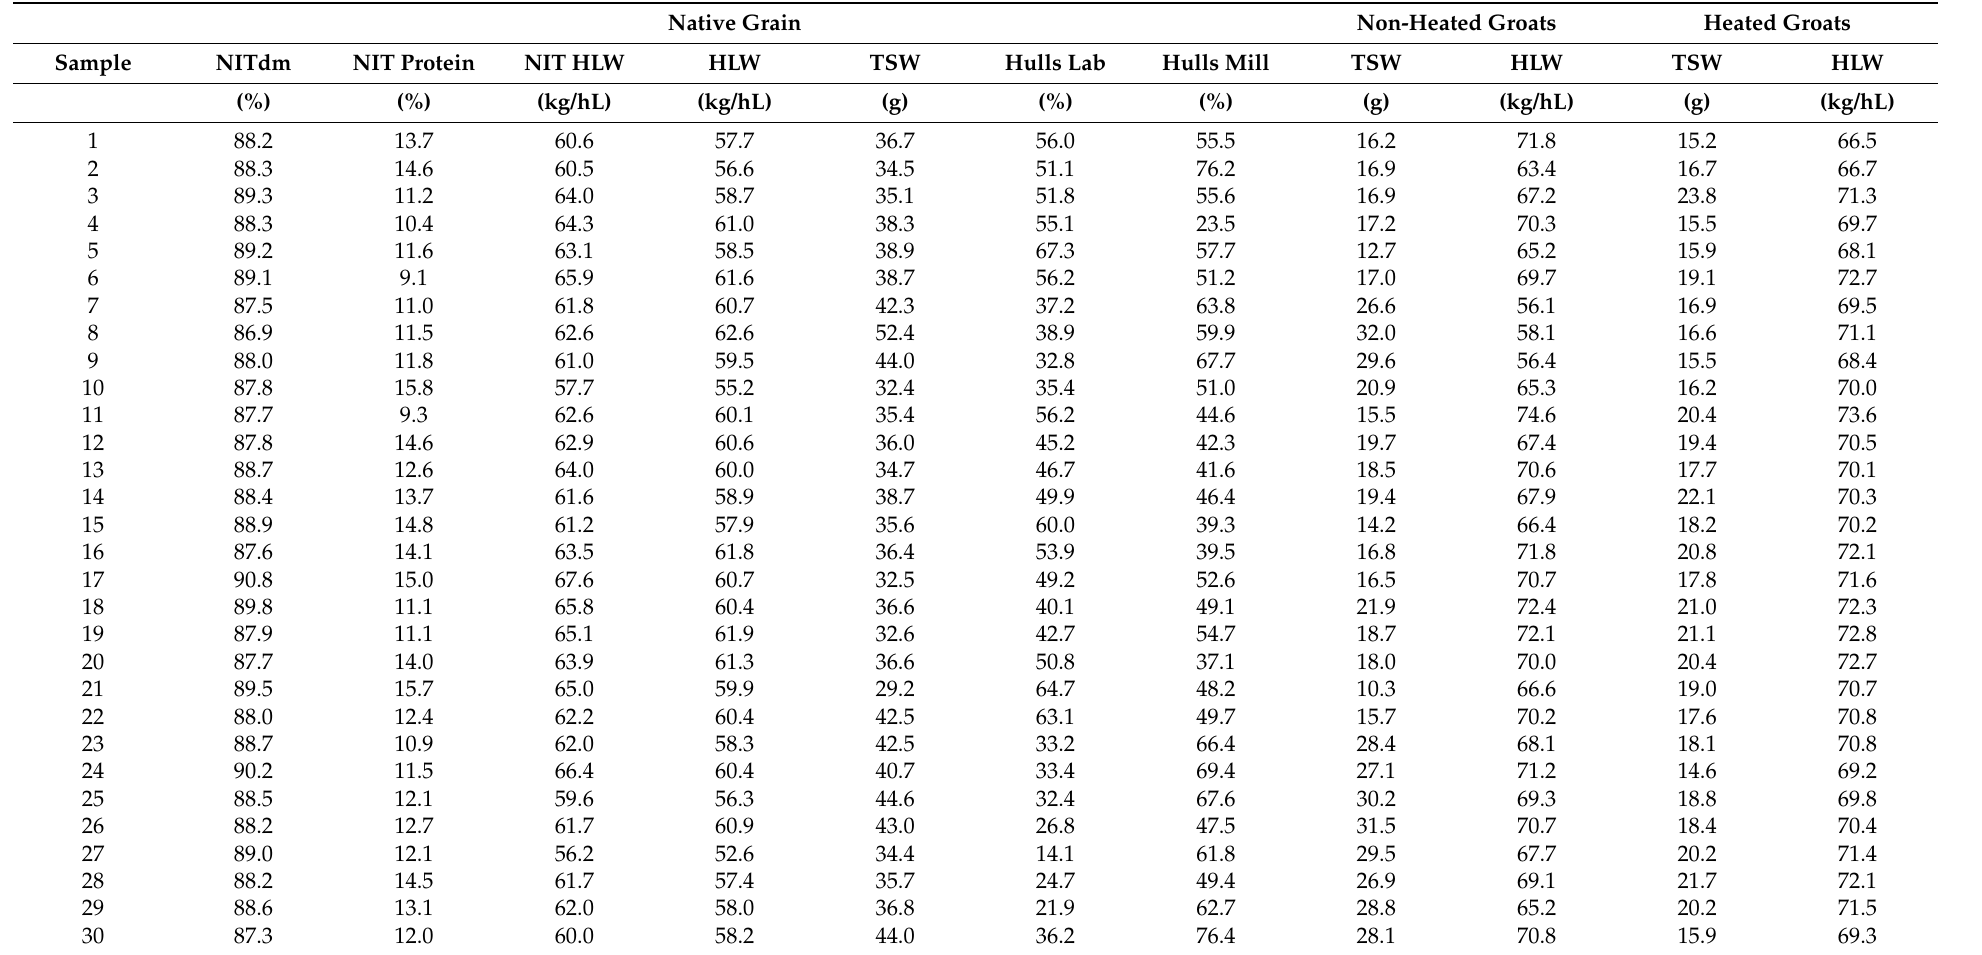
Table A1. Properties of oat grains, non-heated groats and heated groats. NIT, near infra-red transmittance; dm, dry matter; HLW, hectoliter weight; TSW, thousand seed weight. The standard deviations were maximums of 0.3, 0.4, 0.4, 1.0 and 1.0 in the NIT dm, NIT protein, NIT HLW, HLW and TSW,